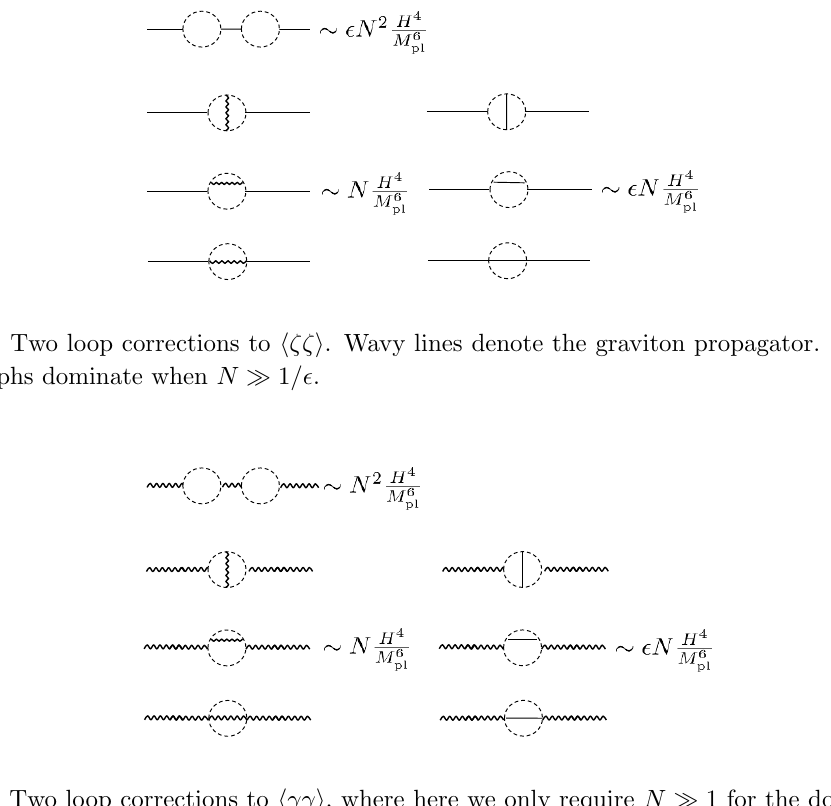
Figure 4 . Two loop corrections to h (cid:13)(cid:13) i , where here we only require N (cid:29) 1 for the double sunset graphs to